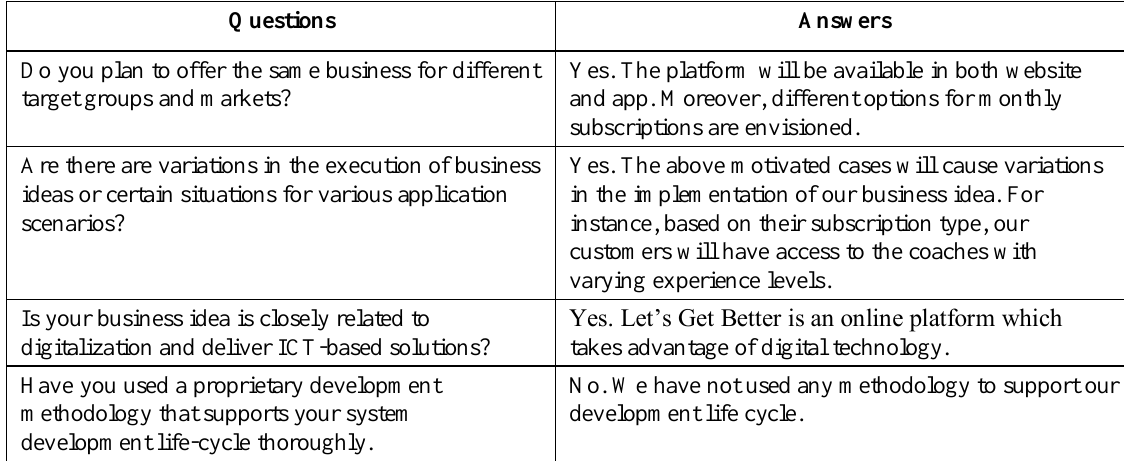
Table 6. Investigating the need for the